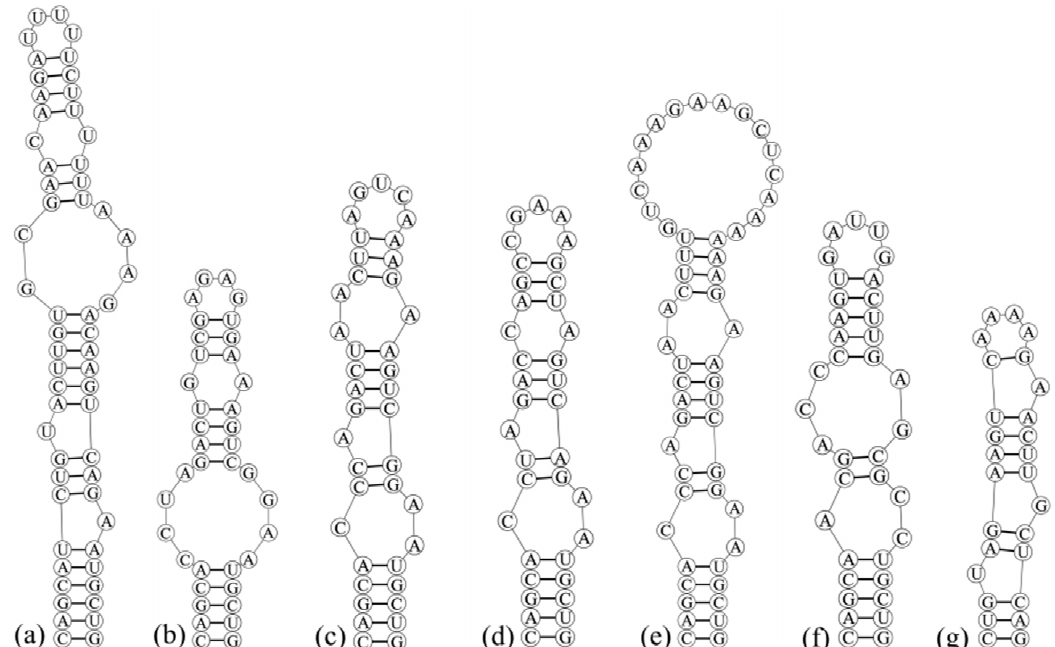
Figure 5. Box–B helix in Microcoleusiopsis ganfuensis and other six related species. ( a ). Microcoleusiopsis ganfuensis CHAB 4138. ( b ). Microcoleus pseudautumnalis AK1609. ( c ). Microcoleus vaginatus CSU-U-KK1. ( d ). Microcoleus vaginatus PTRS-2. ( e ). Microcoleus autumnale SAG 78.79. ( f ) Oscillatoria princeps CCALA 1115. ( g ). Coleofasciculu chthonoplastes MEL.